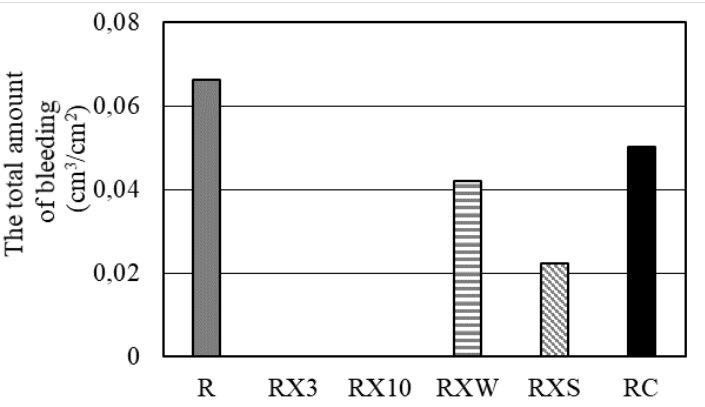
Figure 3. Bleeding